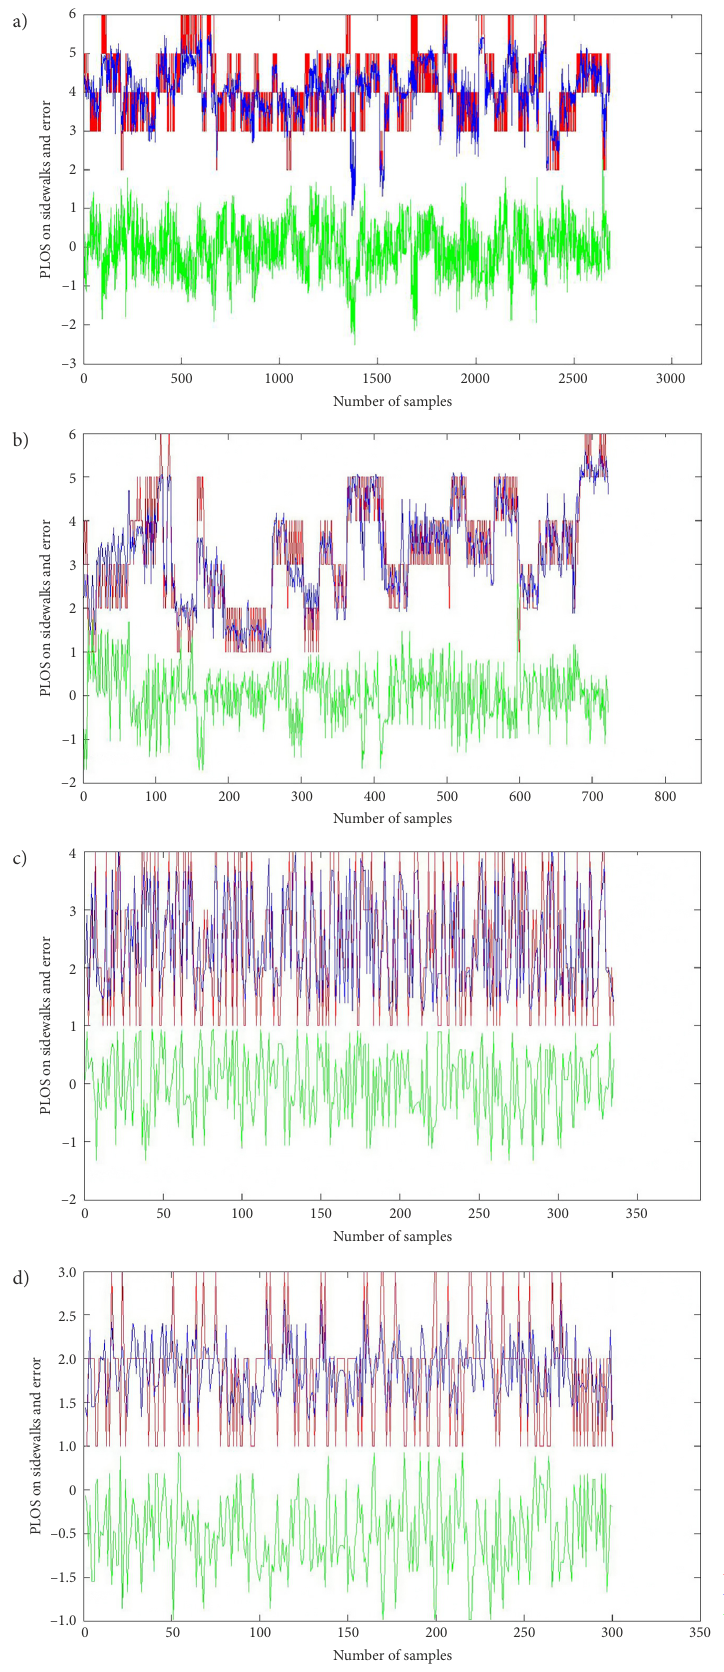
Figure 5. The evaluation (modelling) results of multi-factors affected PLOS and the error curves: a – at level A of pedestrian flow rate; b – at level B of pedestrian flow rate; c – at level C of pedestrian flow rate; d – at level D of pedestrian flow